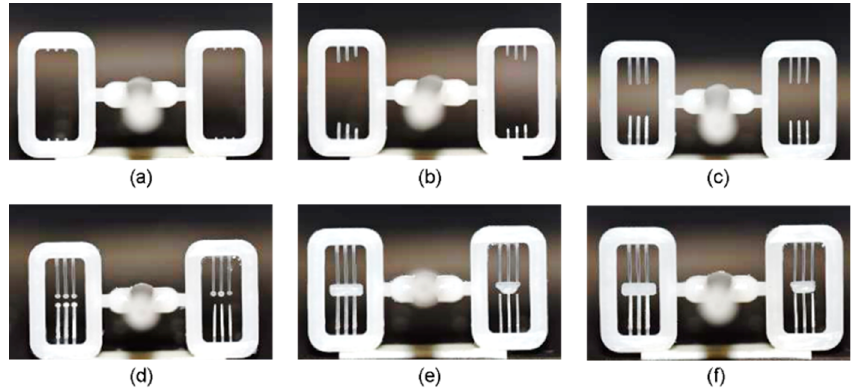
Figure 8. Short shots obtained during melt filling stage, by increasing injection pressure with other factors fixed (Injection pressure of ( a ) 20, ( b ) 25, ( c ) 30, ( d ) 45, ( e ) 55, and ( f ) 65 MPa).